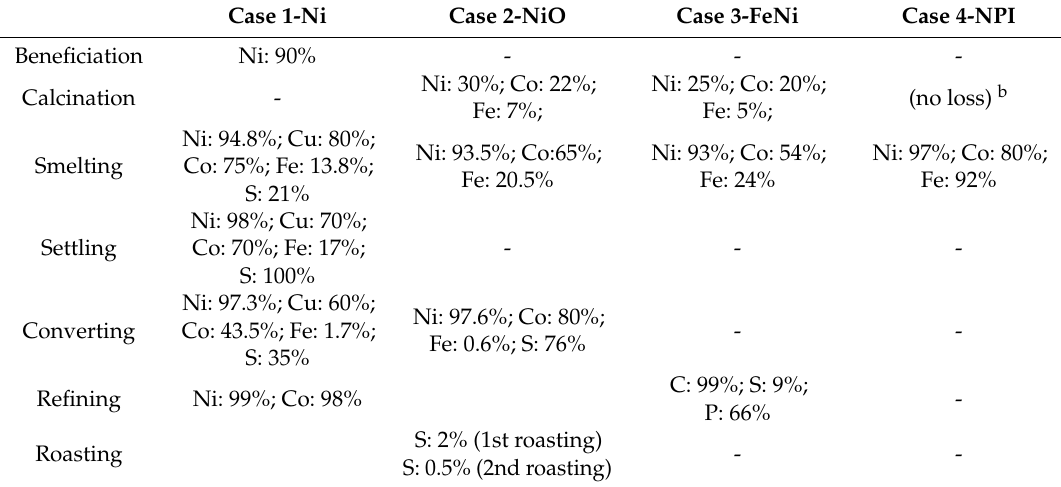
Table 7. Metal recovery rate a during process